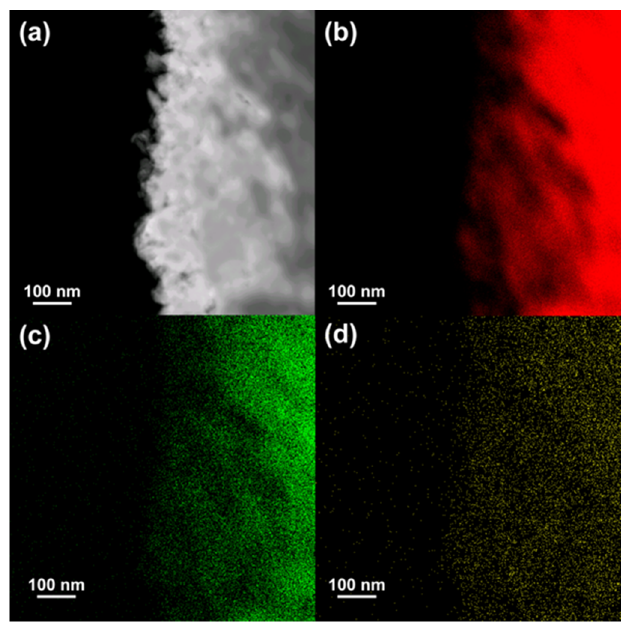
Figure 4. ( a ) STEM image and ( b – d ) energy-dispersive x-ray spectroscopy (EDS) chemical maps of the nanoporous Ni region in the NiYAl 4 -derived sample showing the distributions of Ni (red), Y (green), and O (yellow) elements.